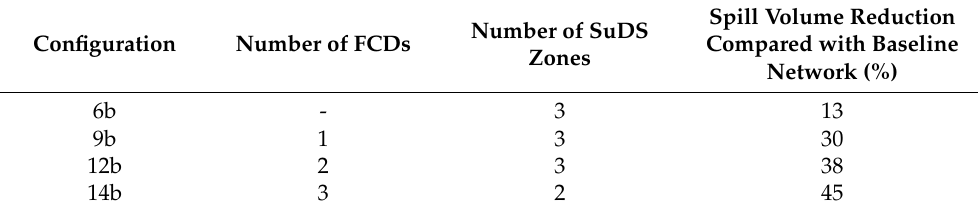
Table 6. Overflow spill volume reduction achieved in the Zona Central catchment model for the 1-year rainfall series based on the numbers and types of intervention measures that were implemented (the overflow spill volume discharged at the regulated CSO in the baseline network was equal to 23,650 m 3 ).